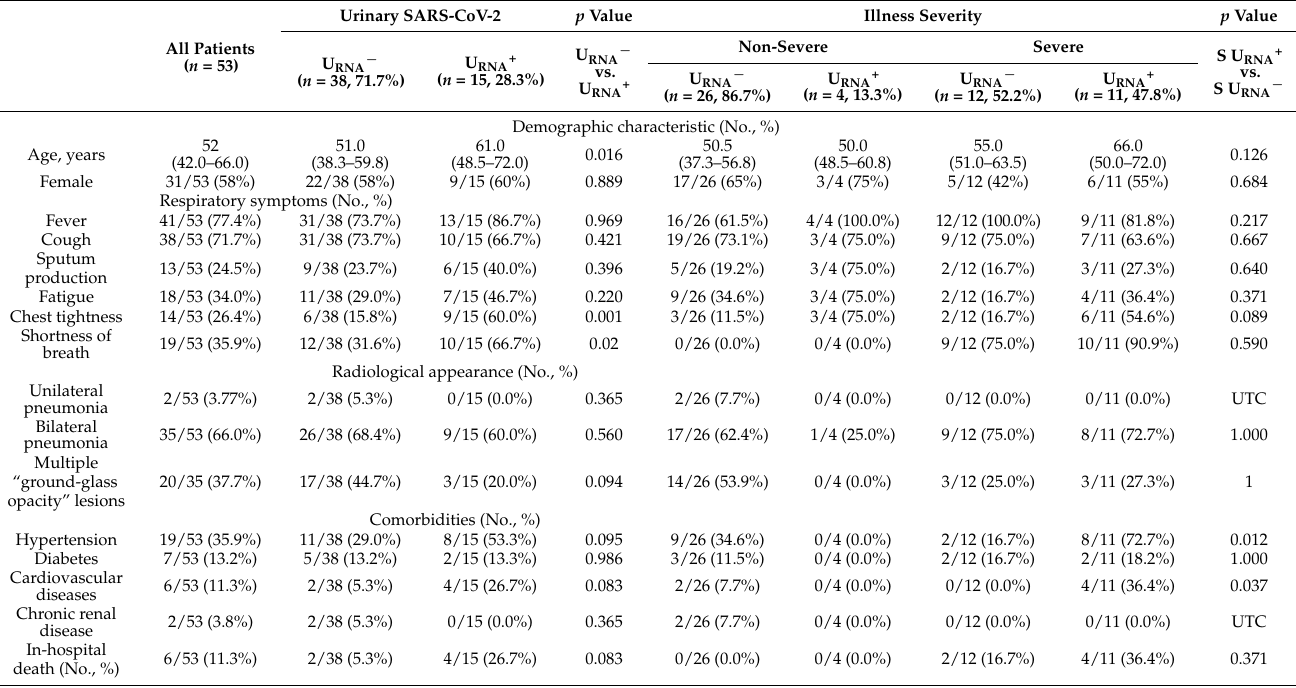
Table 1. Demographic and Clinical characteristics of 53 enrolled patients.